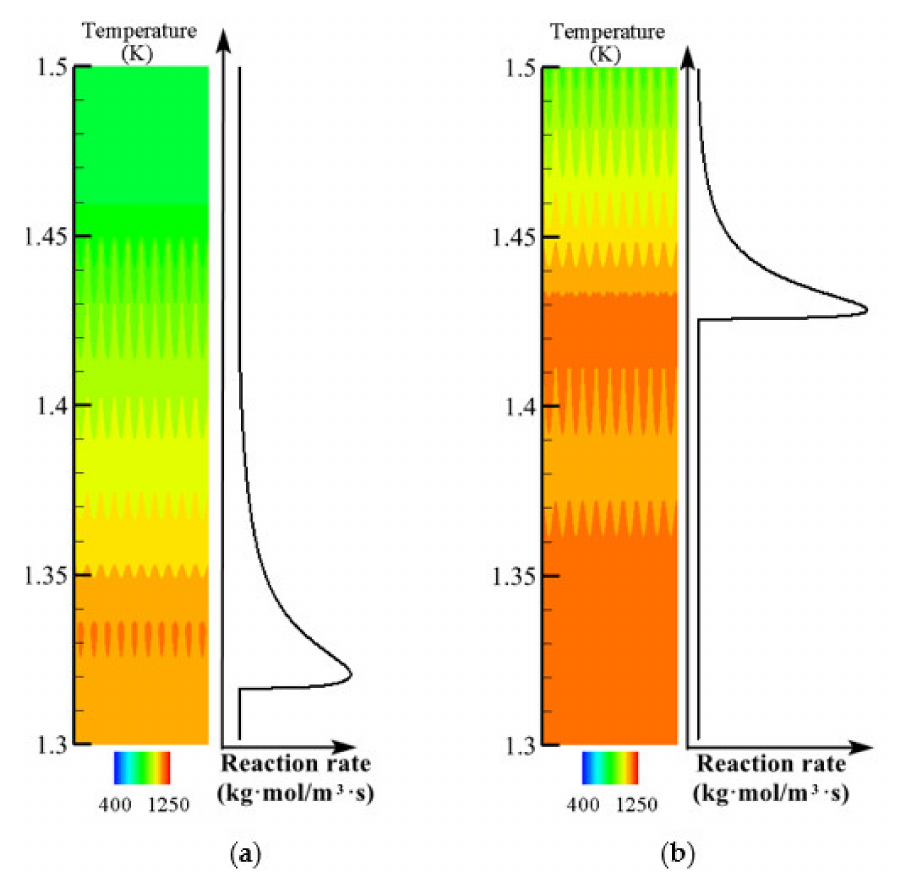
Figure 22. Comparison of temperature field in the reaction zone with an inlet flow rate of 700 m 3 /h, X CH = 0.6%, t = 400 s. ( a ) The initial temperature is set to T 1 ( y ); ( b ) The initial temperature is set 4 to T 4 ( y ).